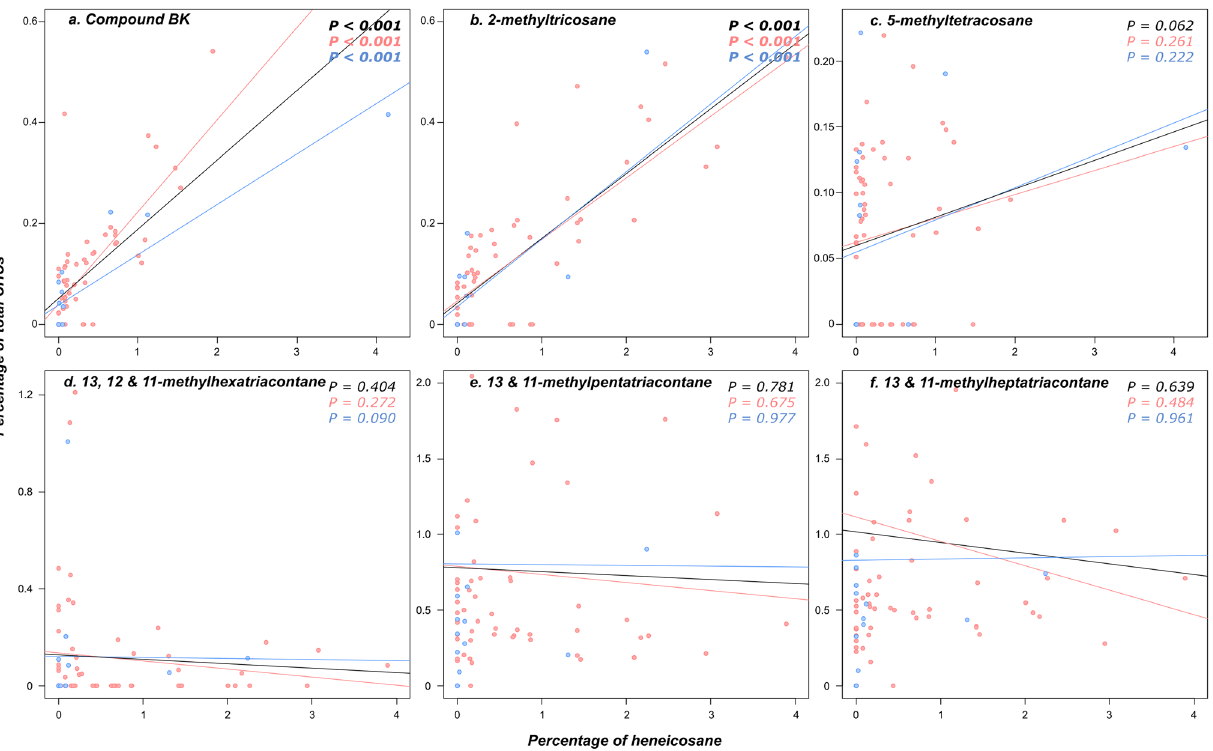
Figure 3. Correlation between the relative proportion of heneicosane and the one of each of the six additional compounds potentially used as royal pheromones by the male and female neotenics ( a Compound BK; b 2-methyltricosane; c 5-methyltetracosane; d 13, 12 and 11-methylhexatriacontane; e 13/11-methylpentatriacontane; f 13, 12 and 11-methylheptatriacontane). Female neotenics are marked in red and male neotenics in